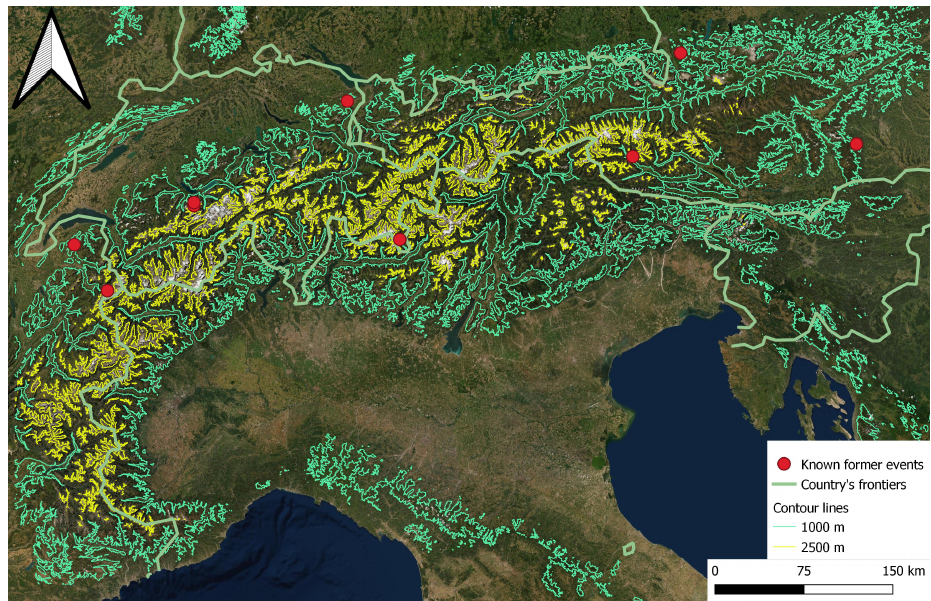
Figure 1. The European Alps encompass parts of France, Switzerland, Italy, Germany, and Austria. Rainfall on an existing snowpack is especially common in an altitude range between 1000 and 2500 m [3]. Including a selection of known hazard events described in Section 2. ESRI Satellite Image and EuroGeographics for the administrative